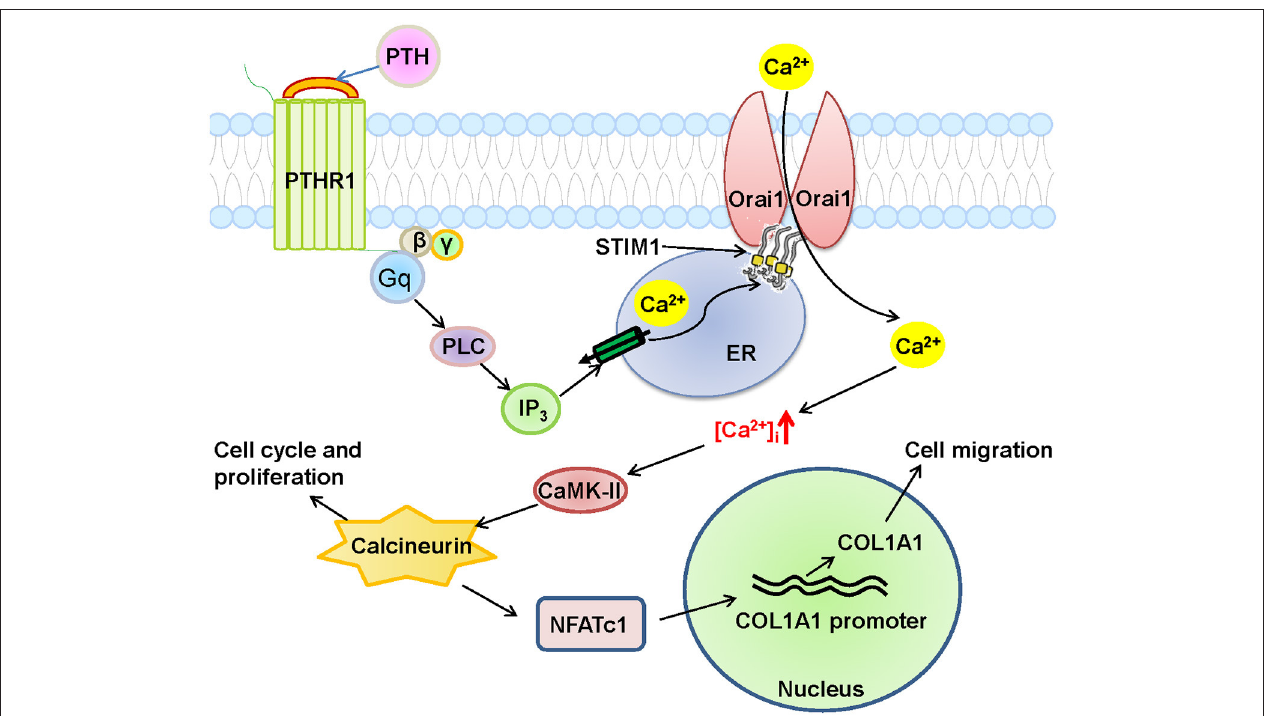
FIGURE 9 | Schematic diagram of Orai1-mediated store-operated Ca 2 + entry (SOCE) signal transduction pathway in human umbilical vein endothelial cells (HUVECs) after parathyroid hormone (PTH) stimulation. In this proposed mechanism, PTH acts on its receptor PTHR1, a G-protein coupled receptor, to produce phospholipase C (PLC) and then inositol triphosphate (IP 3 ), which stimulates its receptor to deplete Ca 2 + stores in the endoplasmic reticulum (ER), leading to the opening of the Orai1 channel in HUVECs to induce extracellular Ca 2 + influx via SOCE. The subsequent increase in intracellular Ca 2 + ([Ca 2 + ] i ) causes the nuclear translocation of NFATC1 through the Ca 2 + /calmodulin-dependent kinase 2 (CaMK-II)/calcineurin signaling pathway, and eventually induces COL1A1 overexpression and HUVEC migration and